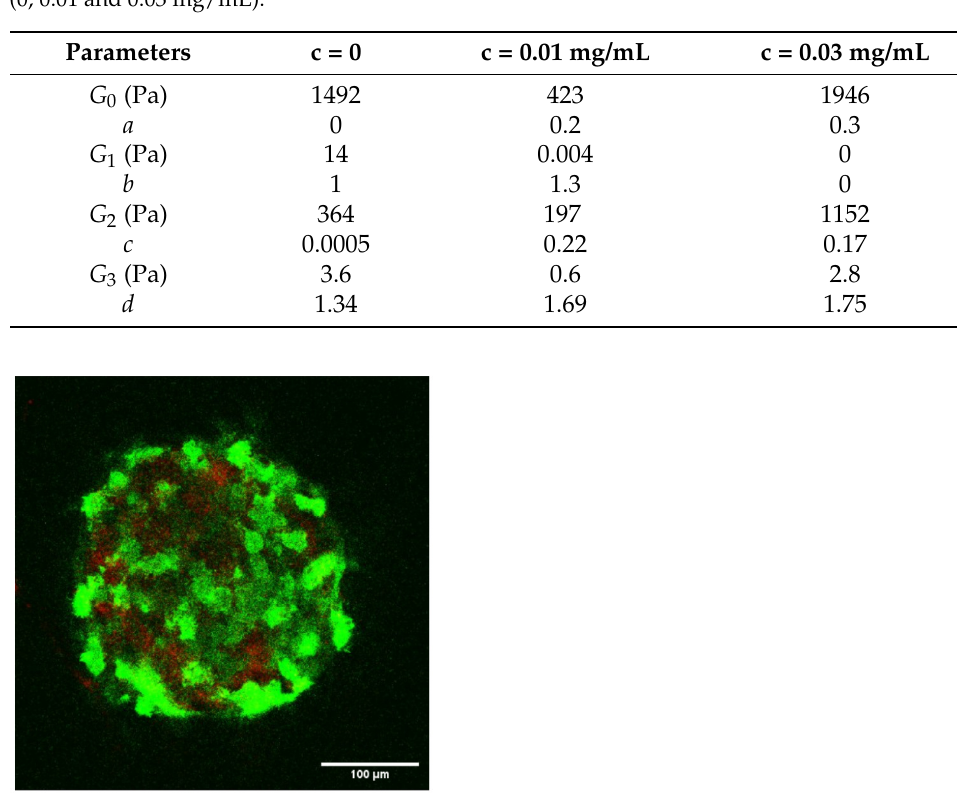
Figure 4. Role of collagen concentration (0–0.01–0.03 mg/mL) on parameters G 0 , G 1 ( A ) and ex- ponents a, b, c, d ( B ). The values of all parameters are reported in Table 1. For each condition, we considered three spheroid sizes ranging from 300 µ m to 410 µ m with G (cid:48) and G (cid:48)(cid:48) averaged for each spheroid diameter (a total of N = 15, 10, 6 experiments for respective collagen concentrations of 0, 0.01, 0.03 mg/mL). The parameters were then extracted by fitting the averaged G (cid:48) and G (cid:48)(cid:48) with the model in Equation (3). The error bars represent the standard error of the mean (SEM). Table 1. Values of the fitting parameters of G 0 , a , G 1 , b , G 2 , c , G 3 , d for different collagen concentrations (0, 0.01 and 0.03 mg/mL).